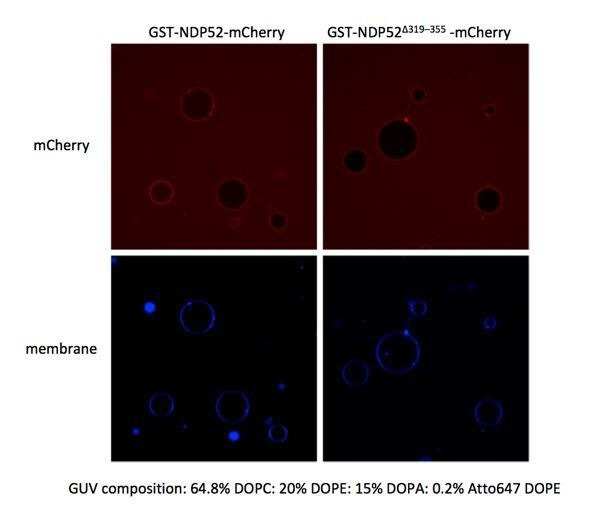
NDP52 binds weakly to PA-containing GUVs.Binding is unaffected by mutation of the putative PA binding sequence of Yu et al.